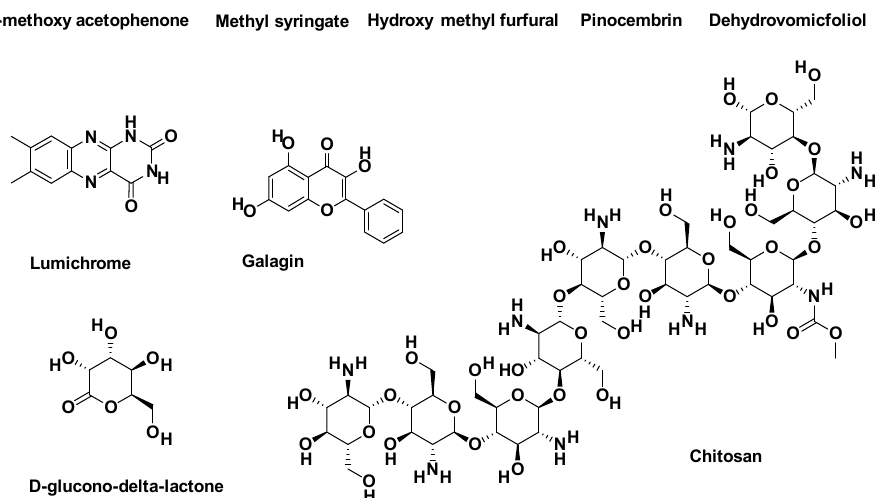
Figure 8. Dataset of 14 compounds used for molecular docking analysis.